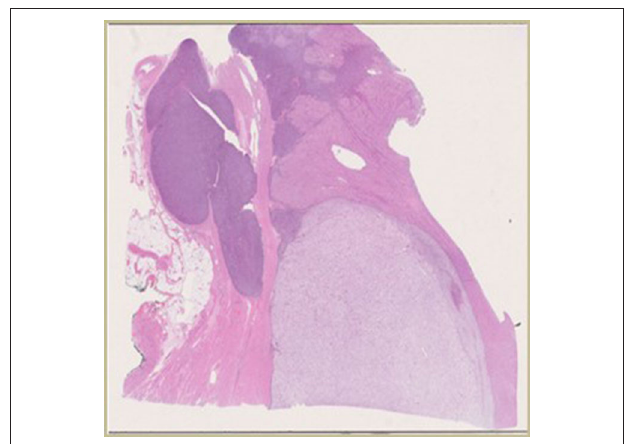
FIGURE 1 | Initial